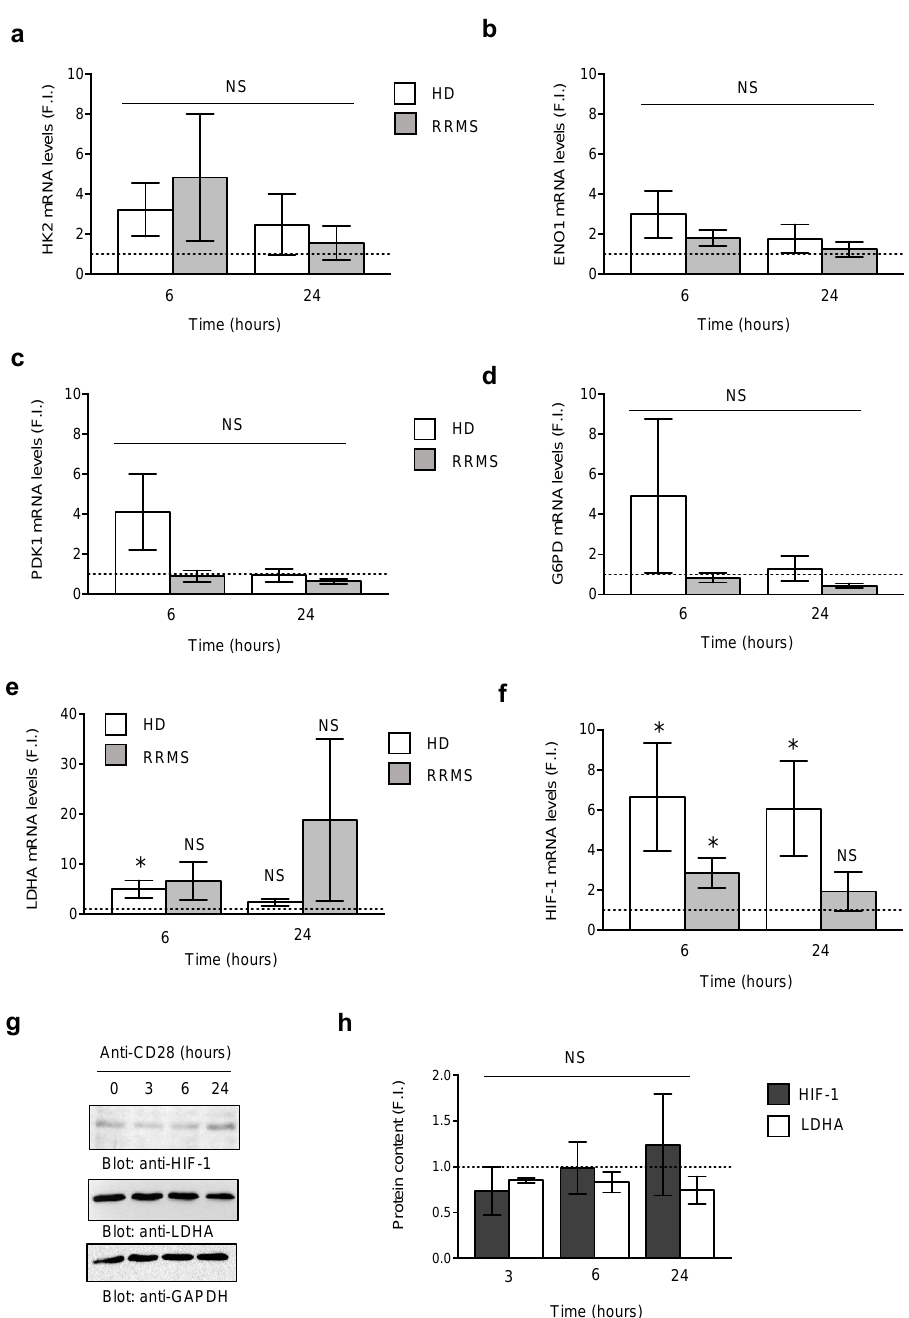
Figure 3. Metabolic profile of CD4 + T cells from HDs or RRMS. ( a–f ) Peripheral blood CD4 + T cells from HD or RRMS patients were activated for 6 or 24 h with 2 µ g mL − 1 isotype control Ig or anti-CD28.2 Abs and mRNA levels of hexokinase 2 (HK2, n = 5), enolase 1 (ENO1, n = 6), pyruvate dehydrogenase kinase 1 (PDK1, n = 6), glucose 6-phosphate dehydrogenase (G6PD, n = 6), lactate dehydrogenase (LDHA, n = 13) and hypoxia factor 1 (HIF-1, n = 13) were measured by real time PCR. The values were expressed as fold inductions (F.I.) over isotype control Ig-stimulated cells after normalization to GAPDH. Data express the mean ± SEM. ( g , h ) HIF-1, LDHA and GAPDH western blotting of CD4 + T cells from HD activated for the indicated times with anti-CD28.2 Abs. ( h ) Fold inductions (F.I.) over isotype control Ig-stimulated cells were quantified by densitometric analysis and normalized to GAPDH levels. Bars represent mean F.I. ± SEM of three HD. Statistical significance was calculated by an unpaired Student’s t test. (*) p < 0.05. NS = not